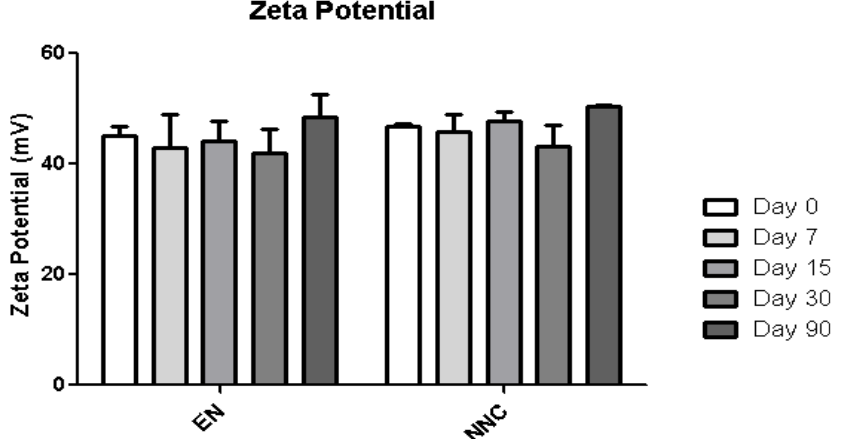
Figure 3. Zeta potential stability of empty nanocapsules (EN) or nicotine containing nanocapsules (NNC) for a period of 90 days of storage. No statistical difference was obtained, signifying that the zeta potential remained stable during the entire period of analysis.